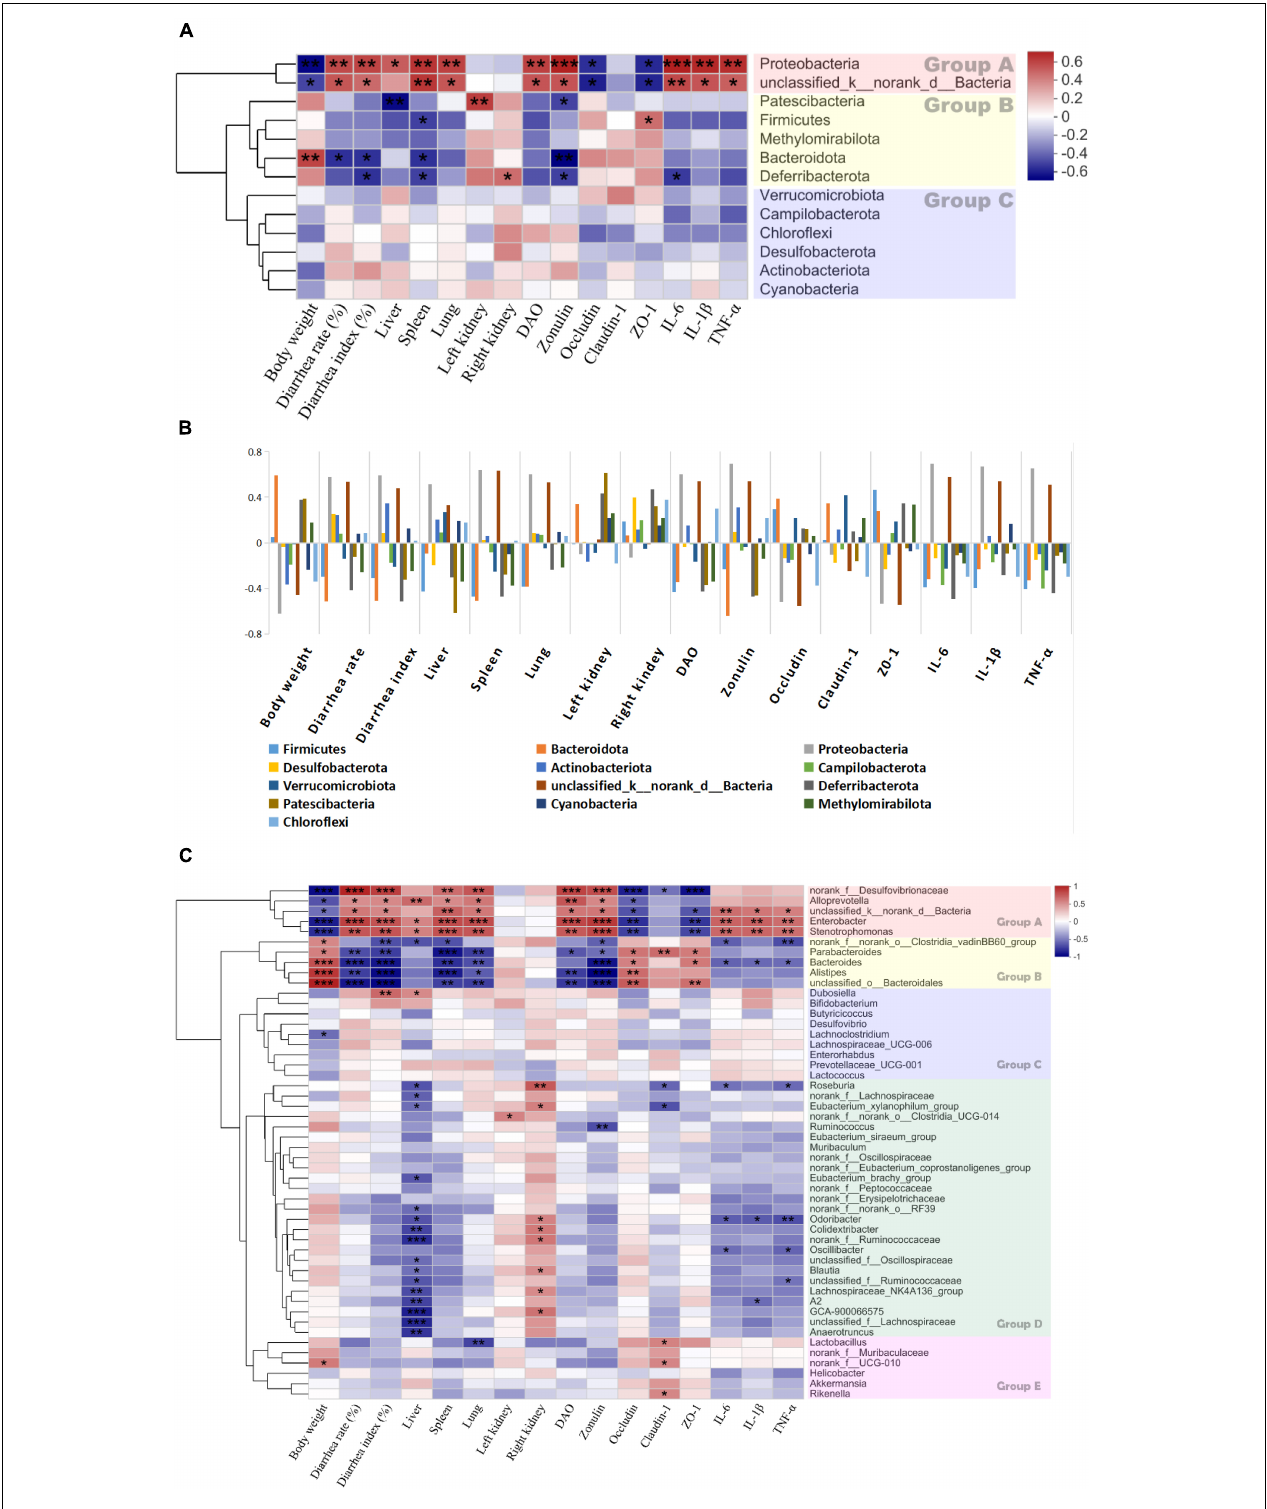
FIGURE 12 | Heatmap of spearman’s correlation between the bacteria and diarrhea-related parameters. (A) The correlation between bacterial phylum and diarrhea-related indexes. (B) The correlation between bacterial phylum and diarrhea-related indexes with histogram. (C) The correlation between bacterial genera and diarrhea-related indexes on day 8. Significant difference determined at * P ≤ 0.05; ** P ≤ 0.01; *** P ≤ 0.001. Groups A, B, C, D and E are formed based on the clustering results of the